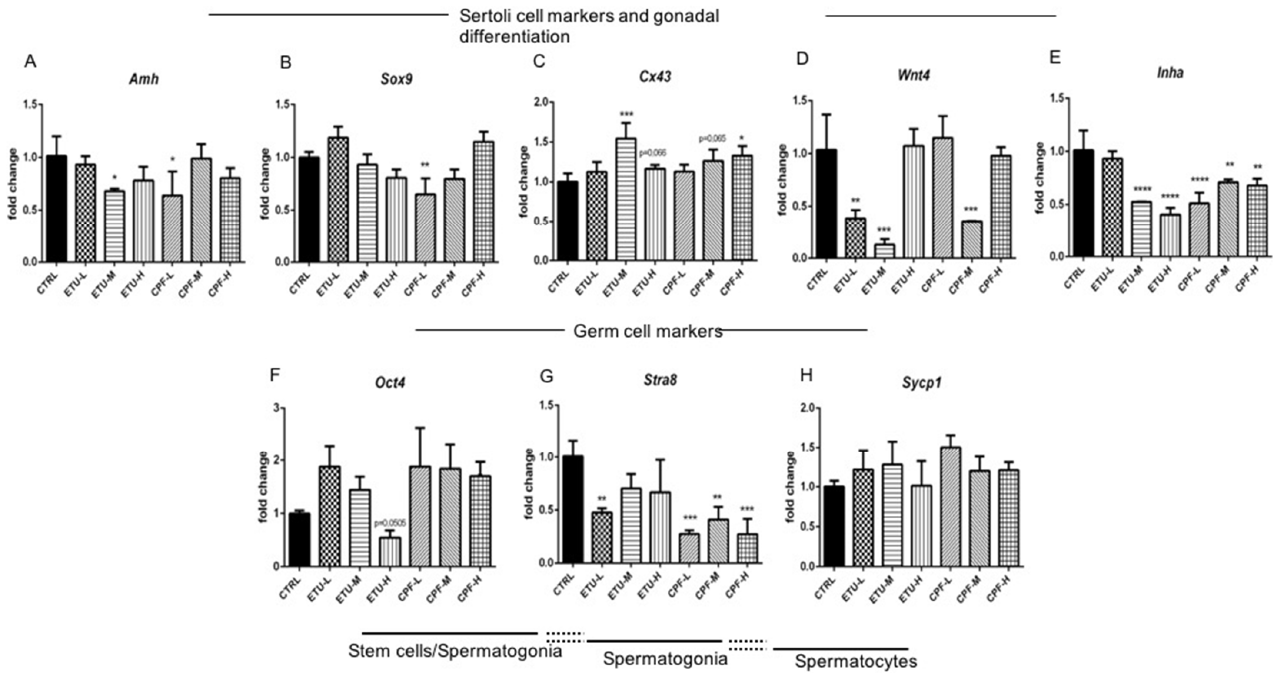
Figure 4. Developmental exposure to CPF and ETU modulates murine regulatory markers of testis function and gamete maturation. RT-qPCR analyses of markers of Sertoli cells ( A – E ) and of germ cells ( F – H ) from mouse adult testes exposed to pesticides since conception until adulthood and control. RT-qPCR analyses were performed on three biological samples (N° = 3 testis/group). Data analysis was conducted as described in M&M section. Data are reported as fold change values calculated as a ratio between average relative gene expression in treated and control, after normalization on β -actin mRNA. Mean and standard deviation are reported. Significant difference from the control group is indicated by * p < 0.05, ** p < 0.01. One-way ANOVA (post hoc test: Dunnett’s) was used.